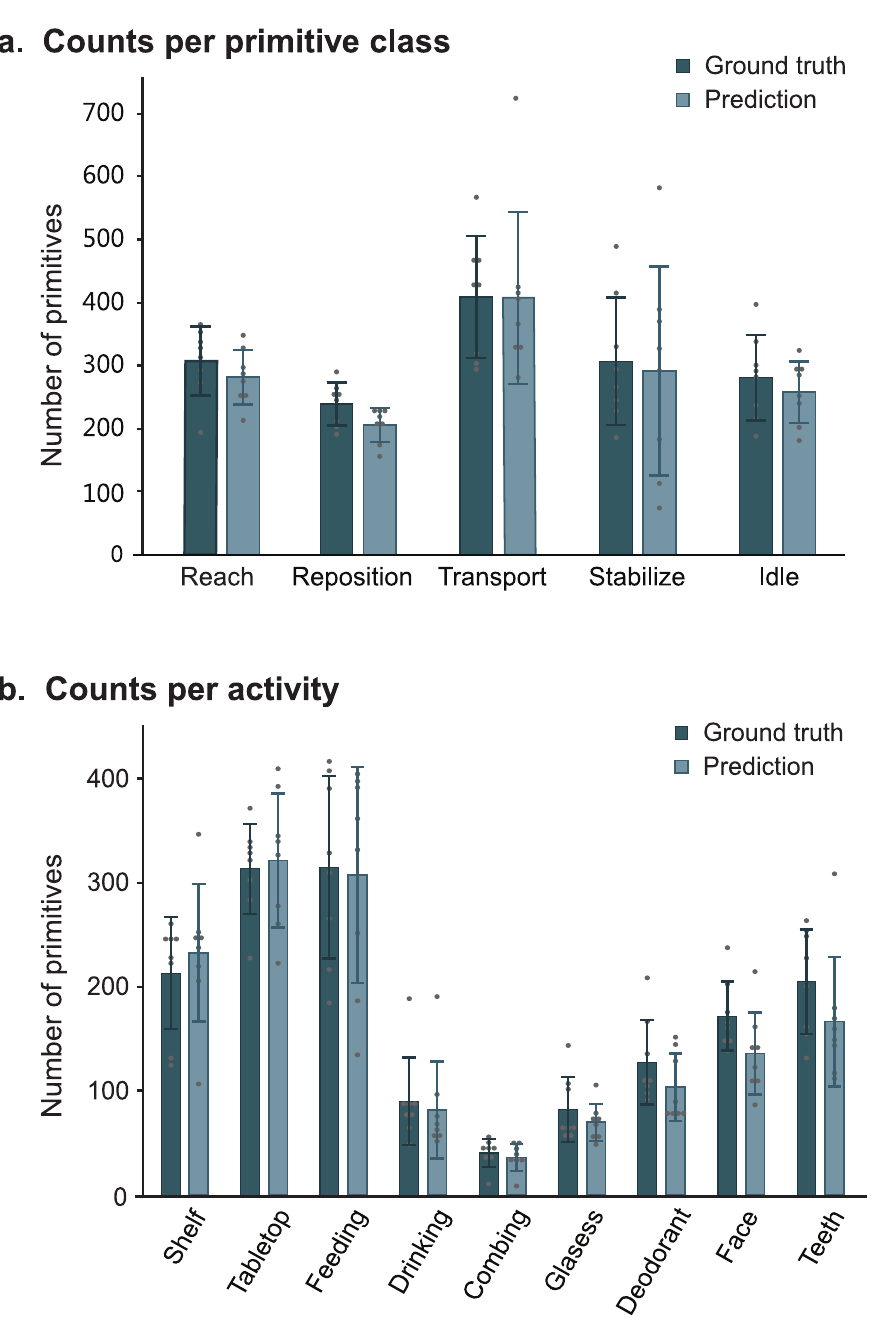
Fig 3. Counting performance of PrimSeq. Shown are the mean ± standard deviation of the ground truth and predicted counts for patients in the test set; each dot represents a single subject. (A) Counts per primitive class . Activities were combined. The pipeline generated counts that were similar to true counts for each primitive class (mean percent of true counts: reach, 92.2%; reposition, 86.6%; transport, 99.5%; stabilization, 91.1%; and idle, 93.3%). (B) Counts per activity . Primitive classes were combined. The pipeline generated counts that were similar to true counts for each activity (mean percent of true counts: shelf task, 109.1%; tabletop task, 102.5%; feeding, 97.6%; drinking, 93.7%; combing hair, 89.8%; donning glasses, 85.2%; applying deodorant, 81.1%; washing face, 79.1%; and brushing teeth, 81.4%).